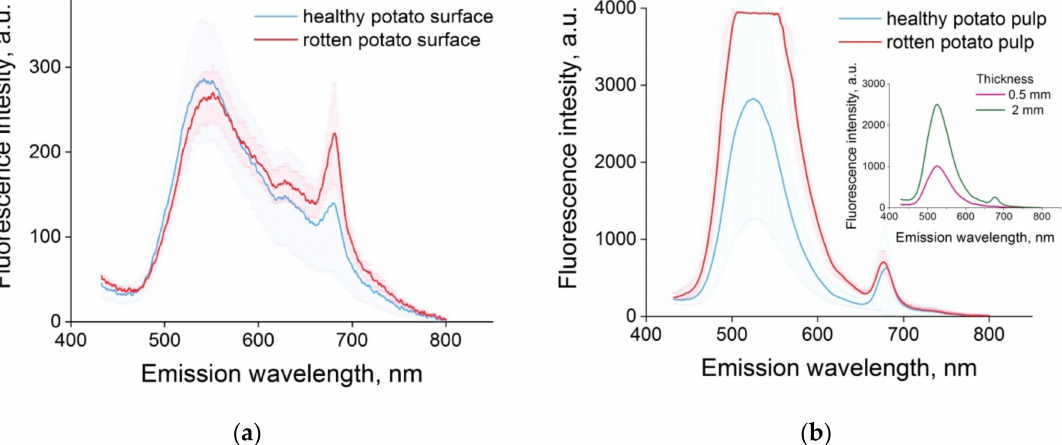
Figure 6. ( a ) Continuous-wave fluorescence spectra of healthy (blue) and rotten (red) surface of potato; ( b ) continuous-wave fluorescence spectra of healthy (blue) and rotten (red) pulp of potato. On the top right, the fluorescence spectra of healthy potato pulp with a thickness of 2 mm (green) and 0.5 (crimson) mm.